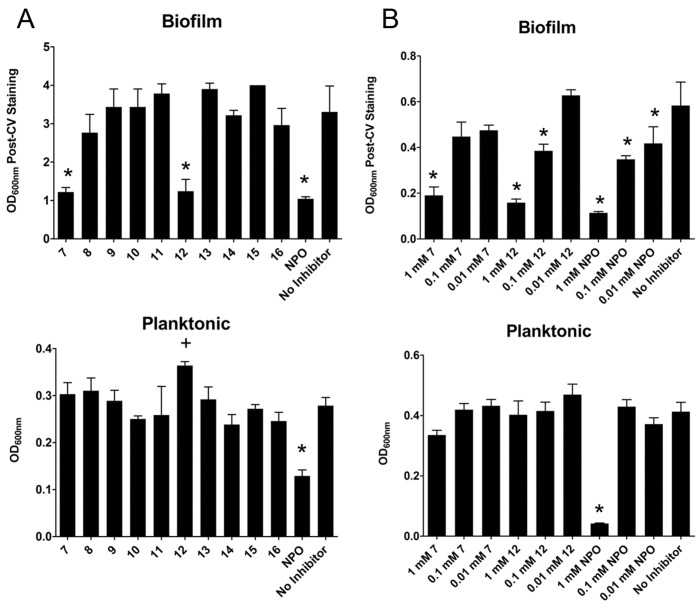
Panel A: Inhibition of P. aeruginosa PAO1 biofilm formation by small molecule inhibitors.Panel B: Concentration dependence for inhibition of P. aeruginosa PAO1 biofilm formation by small molecule inhibitors. For 2A and 2B, average OD600nm measurements of crystal violet stained biofilms (top) and planktonic cells (bottom) are shown with error bars representing one standard deviation (n = 3). ANOVA (p<0.0001) was performed, followed by Tukey’s test, with asterisks (*) indicating significant (p<0.01) reduction in planktonic cell density or biofilm, and (+) representing a significant increase.